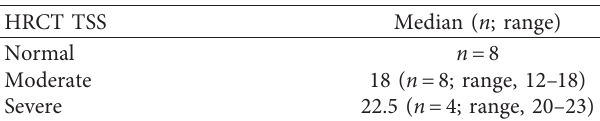
Note. Conversion factors for units: serum creatinine in mg/dL to μ mol/L × 88.4. Laboratory findings of KTRs with SARS-CoV-2 infection are detailed in this table. n values along with median, and ranges of each parameter are tabulated for the entire group. Median and ranges are calculated for the subgroups of KTRs exhibiting either normal or abnormal values for each of the parameter as shown in the table. Table 4: HRCTscores of kidney transplant recipients with COVID- 19 infection. HRCT TSS 22.5 ( n � 4; range, 20–23) The total severity scores (TSS) of kidney transplant recipients with SARS- CoV-2 infection, obtained from the high-resolution chest CT scan, are presented. Data are presented as the number ( n ) of KTRs with normal, moderate, and severe TSS. Median and ranges were calculated wherever available as depicted in the